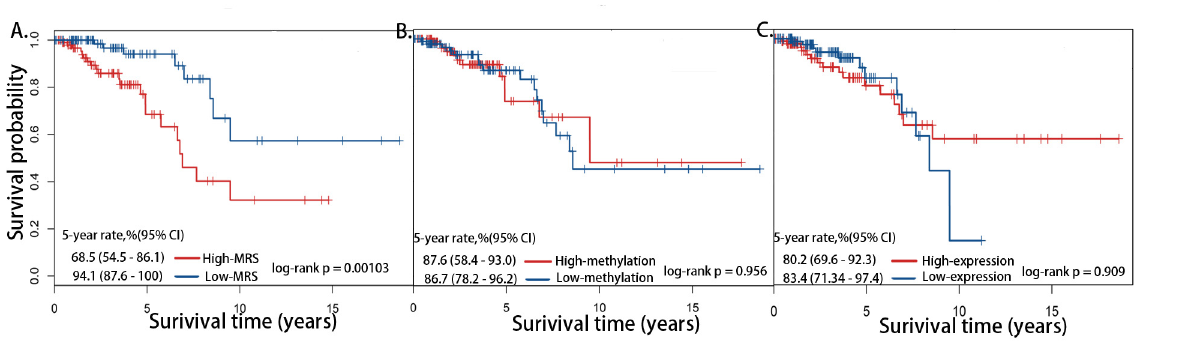
Fig 1. Kaplan-Meier survival analysis of overall survival of 209 breast patients based on feature genes. (A) MRS. (B) Average DNA methylation levels. (C) Average gene expression levels.